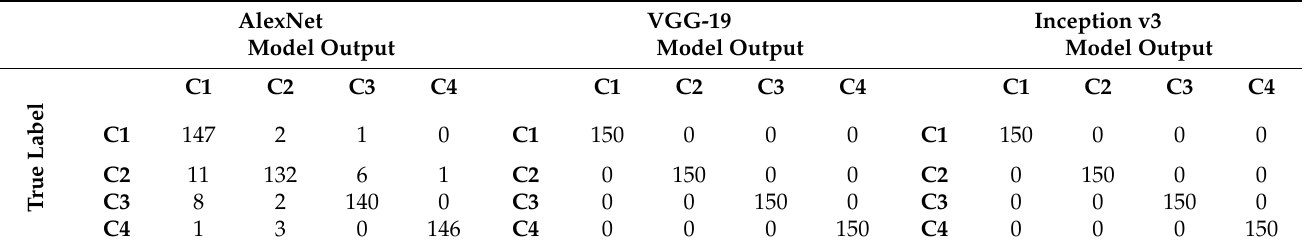
Table 11. Testing phase confusion matrix of the PlantVillage data for each one of the DCNN models that were examined. C1 represents the healthy class, C2 represents the black rot infection, C3 represents the leaf blight spot, and C4 represents the esca infection. AlexNet VGG-19 Inception v3 Model Output Model Output Model Output